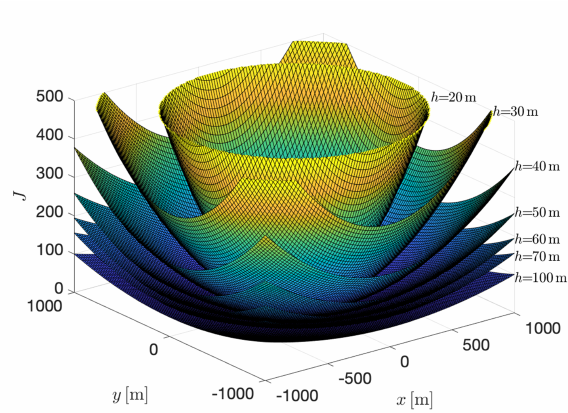
Figure 9. Shape of the hypersurface J for a discrete set of altitudes.